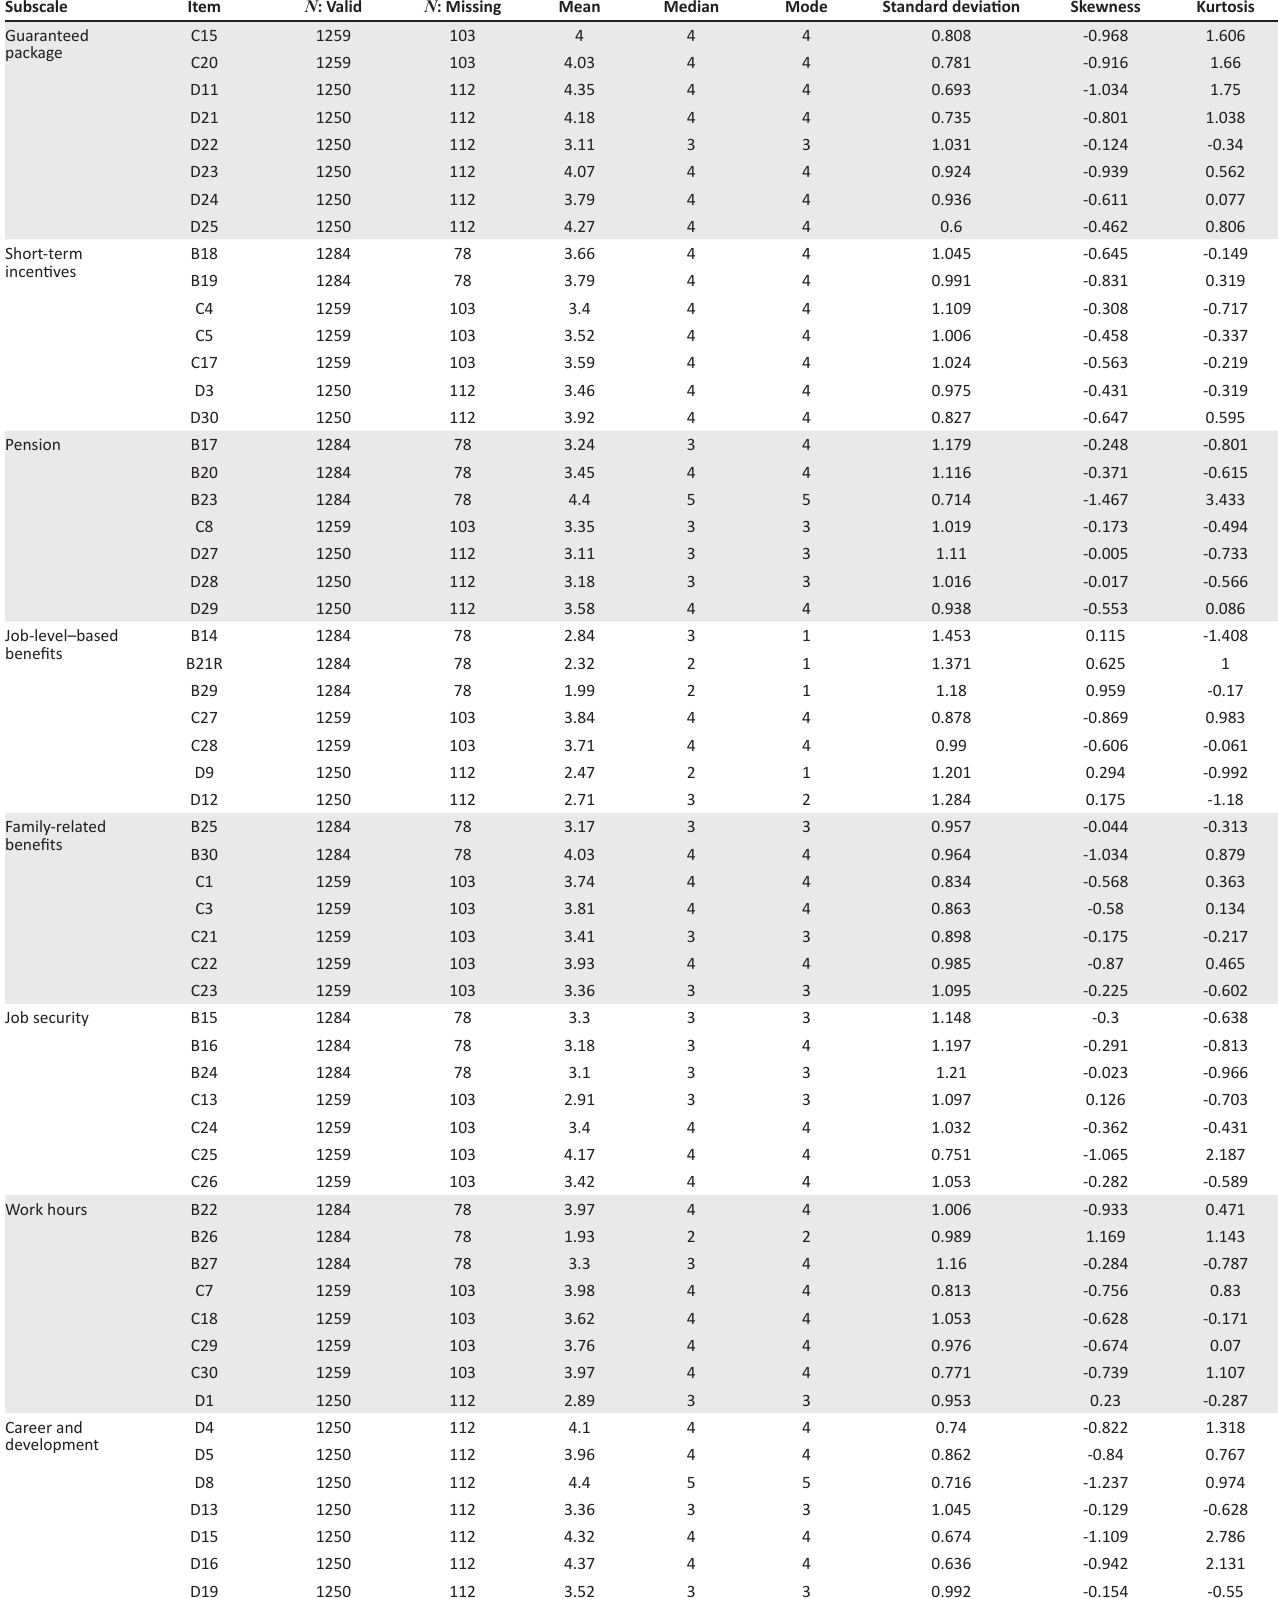
TABLE 5: Descriptive statistics for the reward preference scale